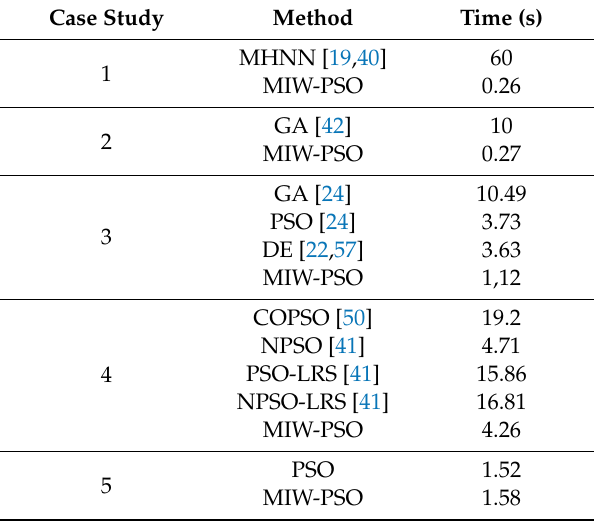
Table 16. Comparison of computation